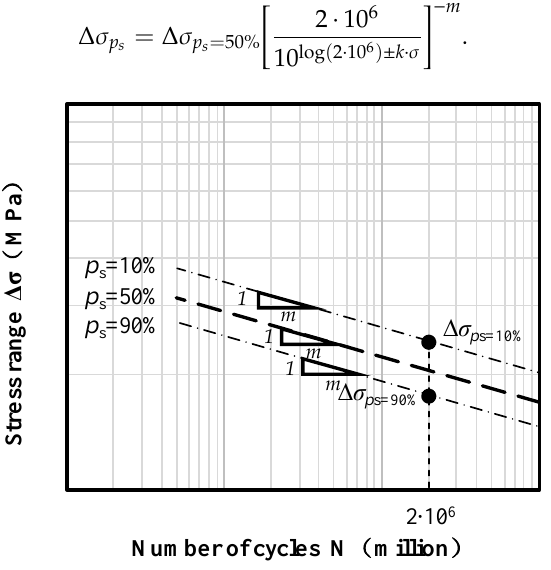
Figure 3. Scatter indexes.